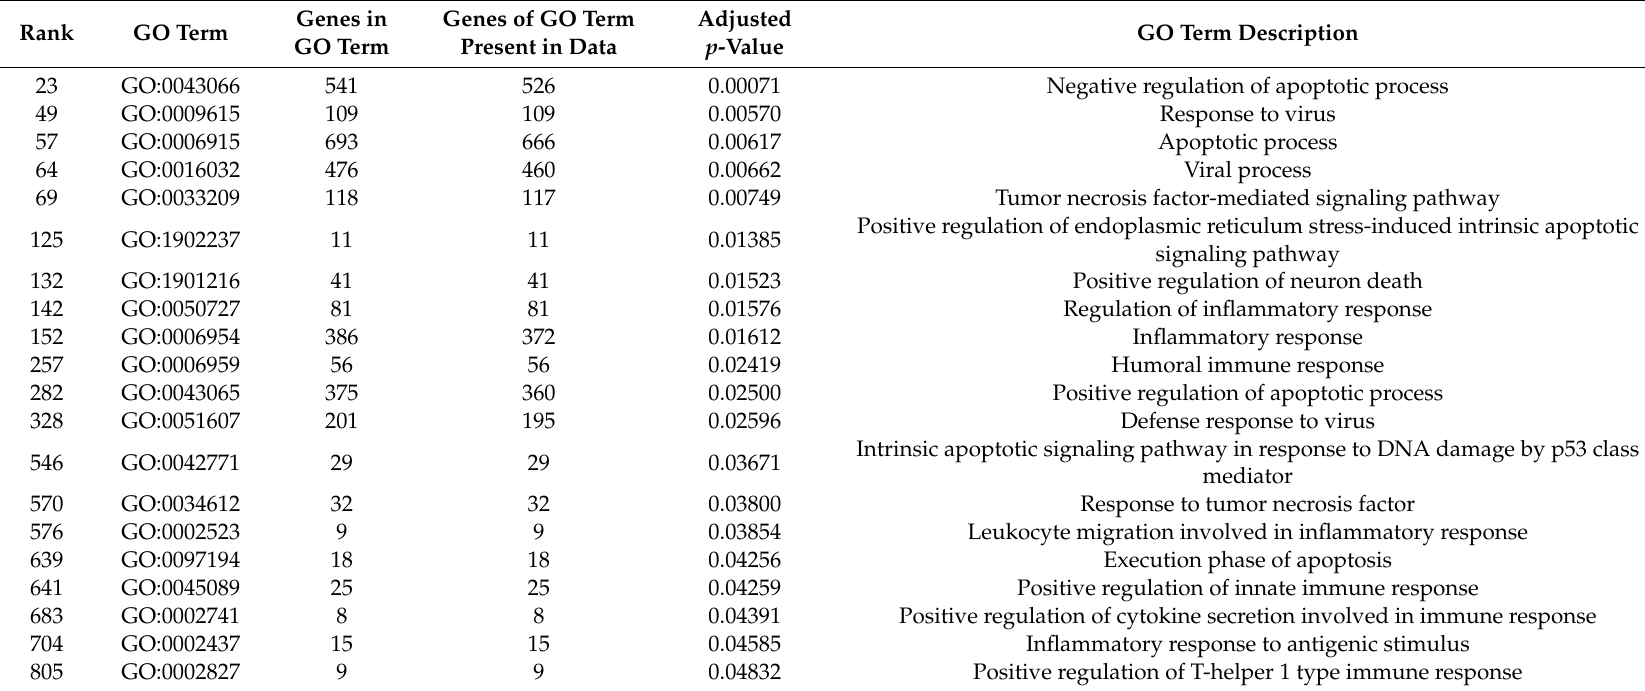
Table 3. List of 20 gene ontology (GO) terms that were enriched in the meta-analysis of three RNA-Seq assays involving human neural stem cells that were experimentally infected in vitro with Zika virus when compared to control cells (false discovery rate (FDR)-adjusted p -values). The complete list of all 847 terms can be found in Supplementary Table